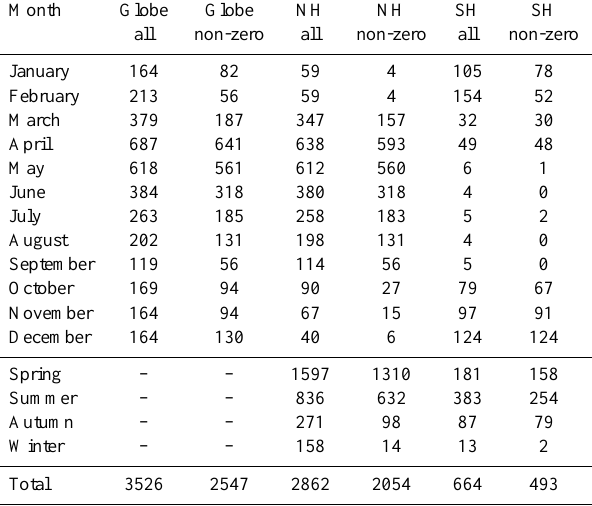
Table 4. Seasonal distribution of abundance data for the North- ern and Southern Hemispheres. Number of data points for each month. All: all data, non-zero: data with non-zero carbon biomass. 27 observations did not include the month when measurements were